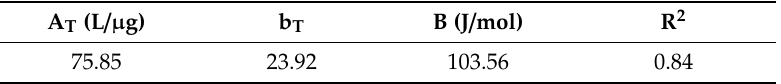
Figure 4. Temkin adsorption isotherm. Table 1. Temkin isotherm constants obtained for the cypermethrin adsorption.